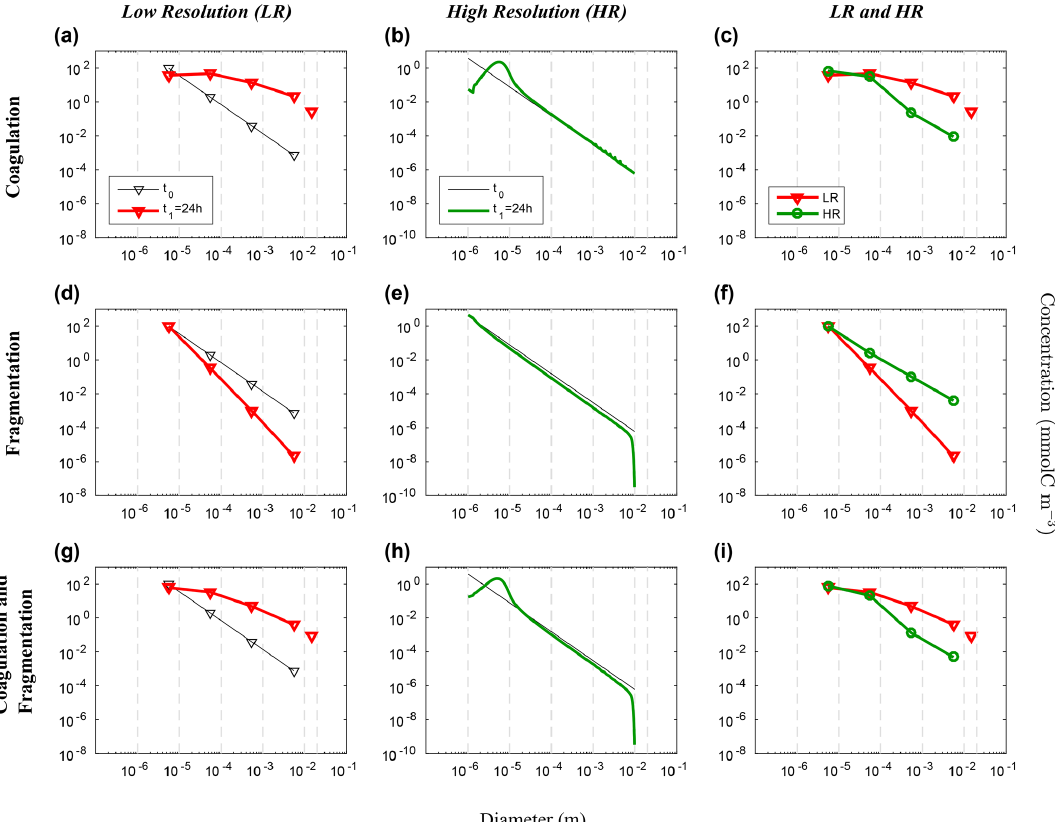
Figure 6. Evolution of the carbon concentration distribution over the size range in our nonlinear size discretization configuration (E2) as function of diameters. Our three sets of reaction simulations are represented: coagulation only ( a–c ), fragmentation only ( d–f ) and when both reactions are combined ( g–i ). The left column (a,d,g) represents our LR setup, the middle column (b,e,h) the HR one and the right column (c,f,i) the comparison of the HR carried back to LR (see Eq. 25 in Sect. 3.1 for details). Y abscissas are different between our resolutions and are set to allow an easy comparison. For each panel, the initial time step t 0 is in black and the final time step t 1 = 24h appears N for both resolutions, as they represent the average of a larger in red for LR and in green for HR. Solitary points represent the size bin 3 2 number of size bins (LR: 5 to 8, and HR: 401 to 800) than the ones in the resolved range. Notice that the final carbon concentration in the unresolved bin of the HR experiment is divided by a factor of 100 in order to fit in the y scale. As detailed in the methods (Sect. 2.3), both coagulation and fragmentation reactions occur in the resolved range but only fragmentation occurs in the unresolved range. For further details, refer to the legend of Fig.